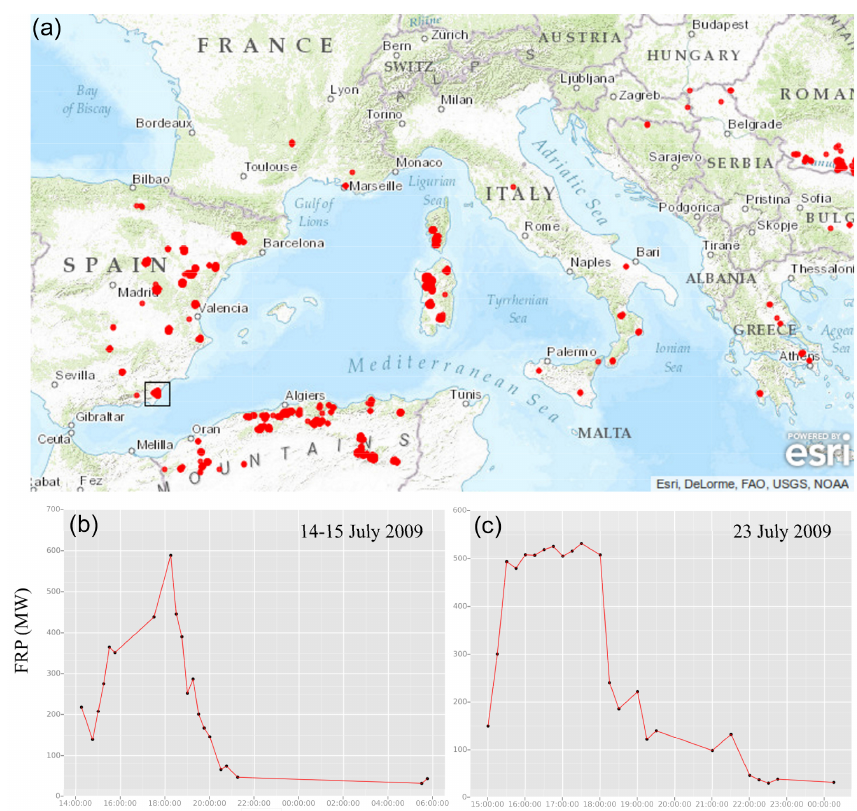
Figure 22. High FRP active fire detections made across parts of Europe and North Africa (4.0 ◦ E–35.0 ◦ W, 25.0–46.0 ◦ N) in July 2009 and stored in the SEVIRI FRP-PIXEL product. (a) The locations of active fire pixels with FRP ≥ 200MW, with the location of the wildfire close to the Sierra Cabrera in Spain (37.15 ◦ N, 1.92 ◦ W), are outlined; their FRP time series are shown in (b) and (c)